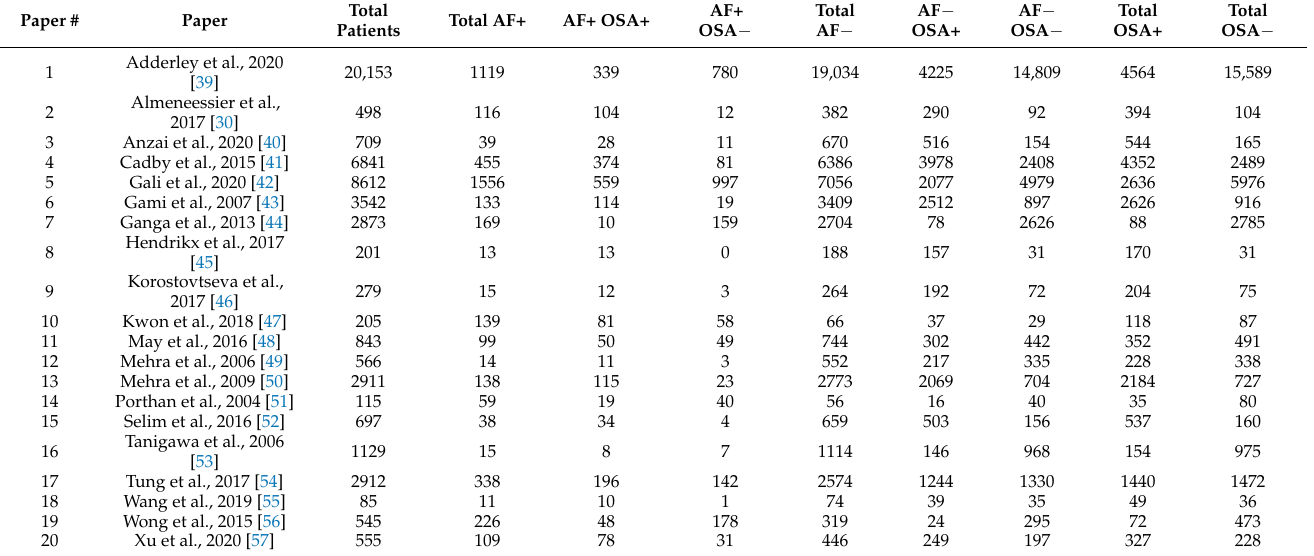
Table 1. Patients’